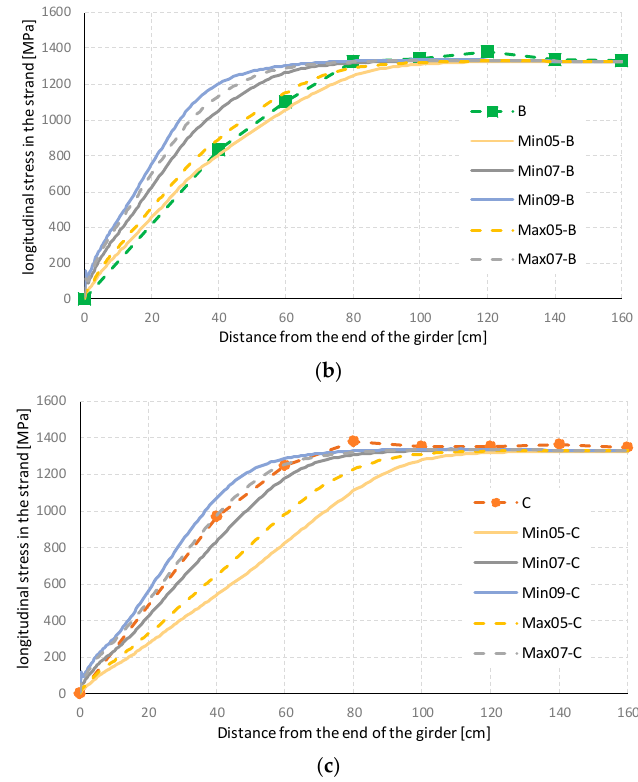
Figure 17. Longitudinal stresses obtained from the FE model and experimental results: ( a ) Strand A ( top ); ( b ) Strand B ( middle ); ( c ) Strand C ( bottom ).